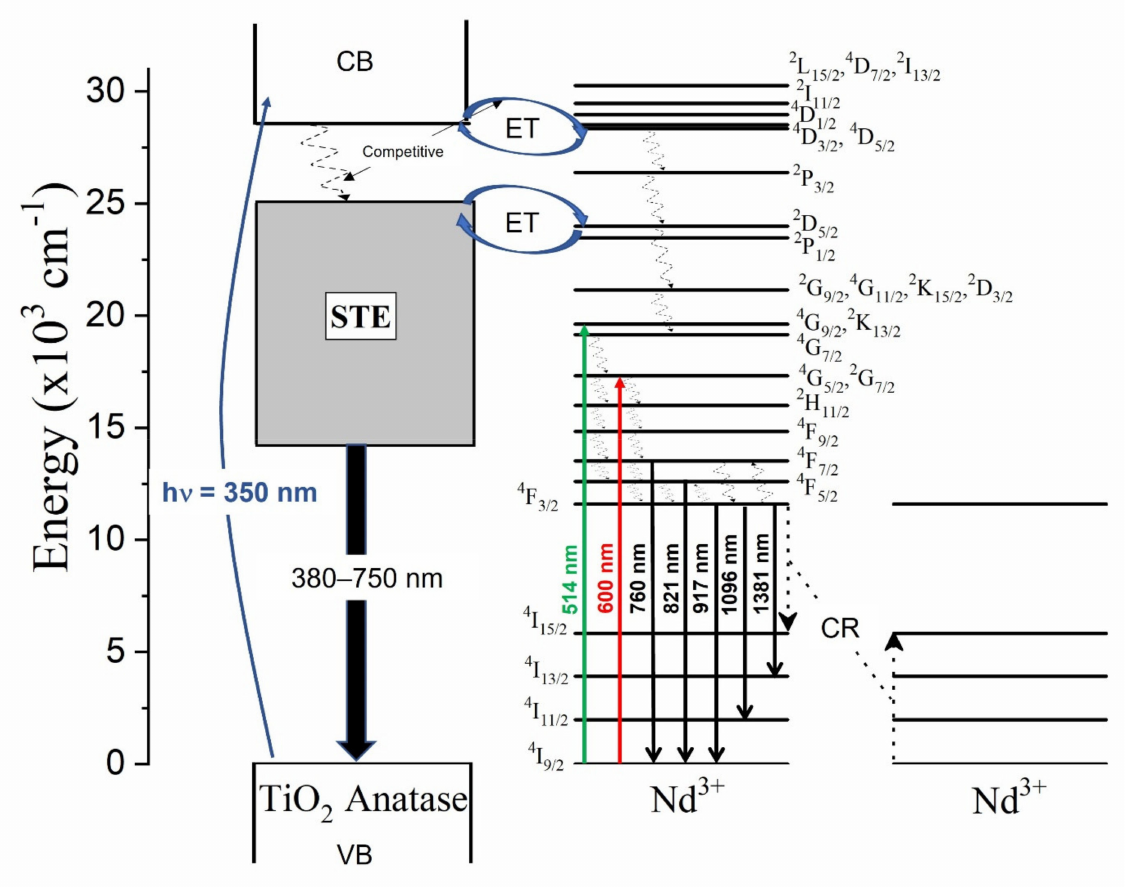
Figure 4. Energy level diagram of Nd 3+ –TiO 2 under excitation at 350, 514 and 600 nm presenting the radiative, energy transfer, non-radiative and cross-relaxation